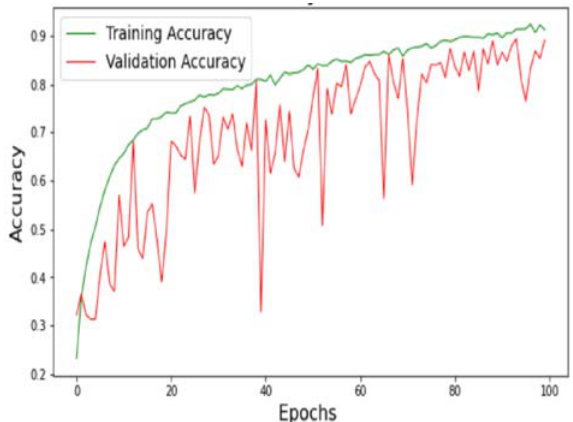
Figure 6. Accuracy Curves